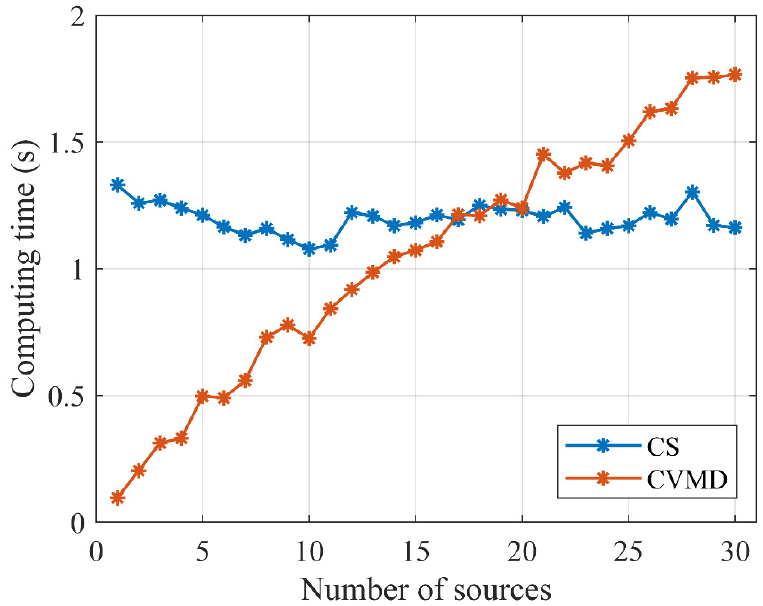
Figure 5. Comparison of computation time for 30 sensors between the CS and CVMD-based methods with the different number of sources.